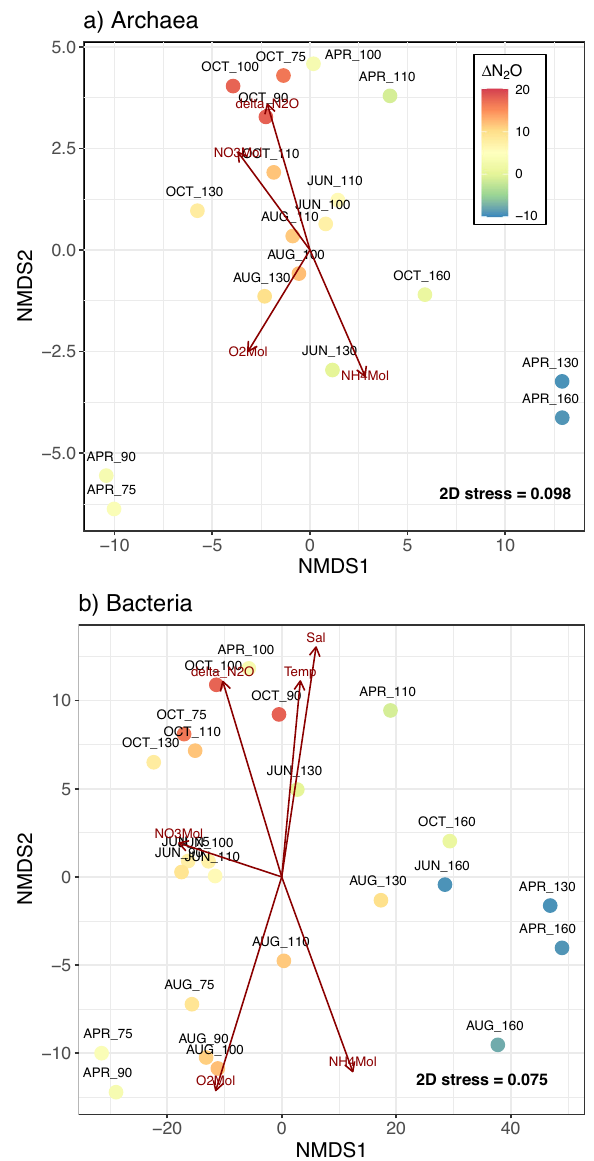
Fig. 2 Environmental drivers of community dissimilarity. Nonmetric multidimensional scaling (NMDS) ordinations for a Archaea and b Bacteria communities. NMDS analyses were conducted using Aitchison distances between samples calculated using clr-transformed ASV tables. Signi fi cant environmental predictors of community dissimilarity were calculated using env fi t and the corresponding vectors are represented by red